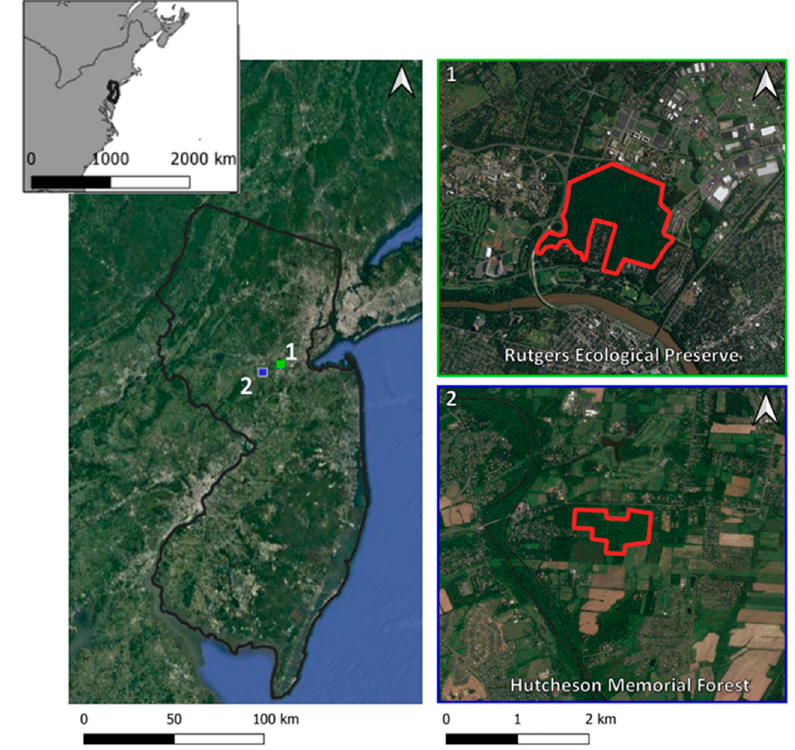
Figure 1. Location of the Rutgers University Ecological Preserve (RUEP, 1) and Hutcheson Memorial Forest (HMF, 2) within New Jersey on the East Coast of the United States. Imagery shows the differences in landscape surrounding these two areas, with the RUEP surrounded primarily by Rutgers University and residential land while HMF is surrounded primarily by agricultural and residential land. Images from Google Earth (2017).